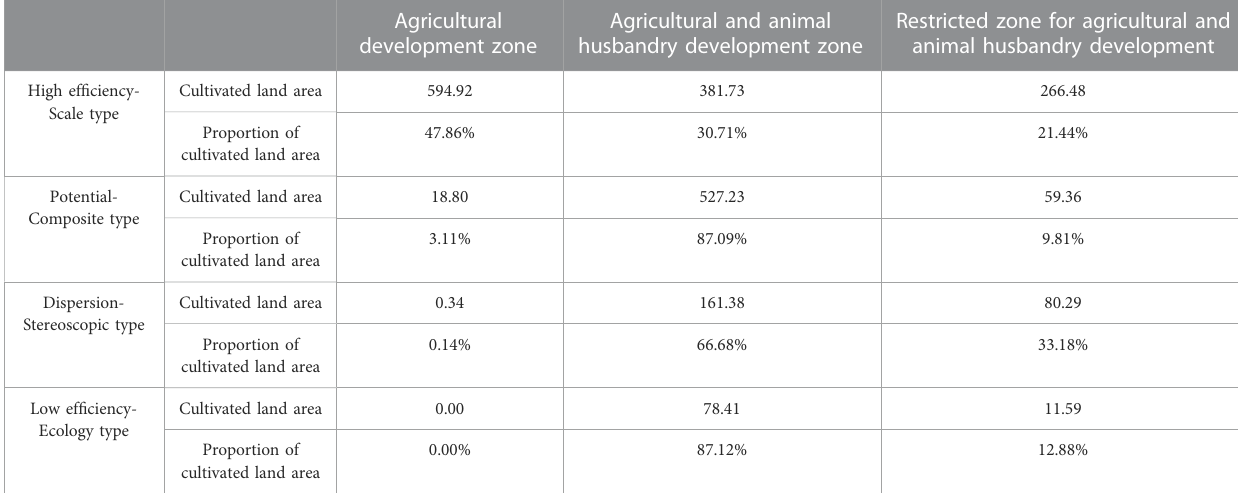
TABLE 5 Number of counties and cultivated land area in optimized subregions of cultivated land use